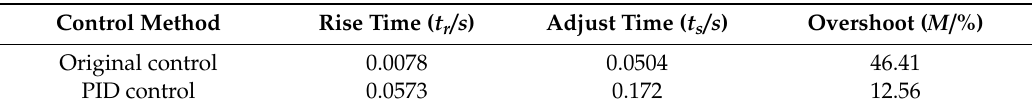
Figure 5. Proportional–integral–derivative (PID) control Simulink simulation results. Table 3. PID control simulation data.